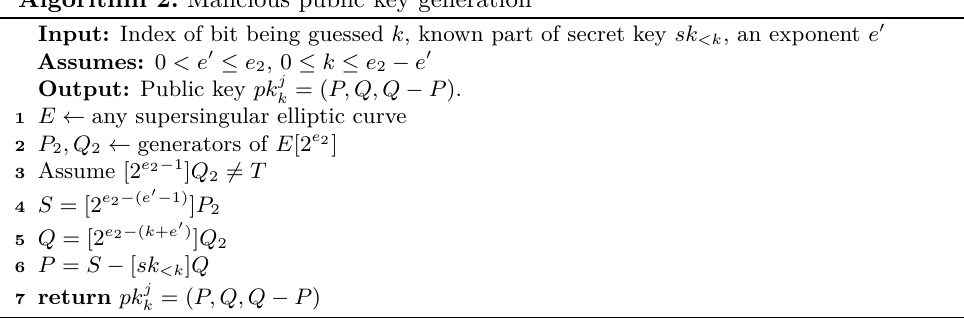
Algorithm 2: Malicious public key